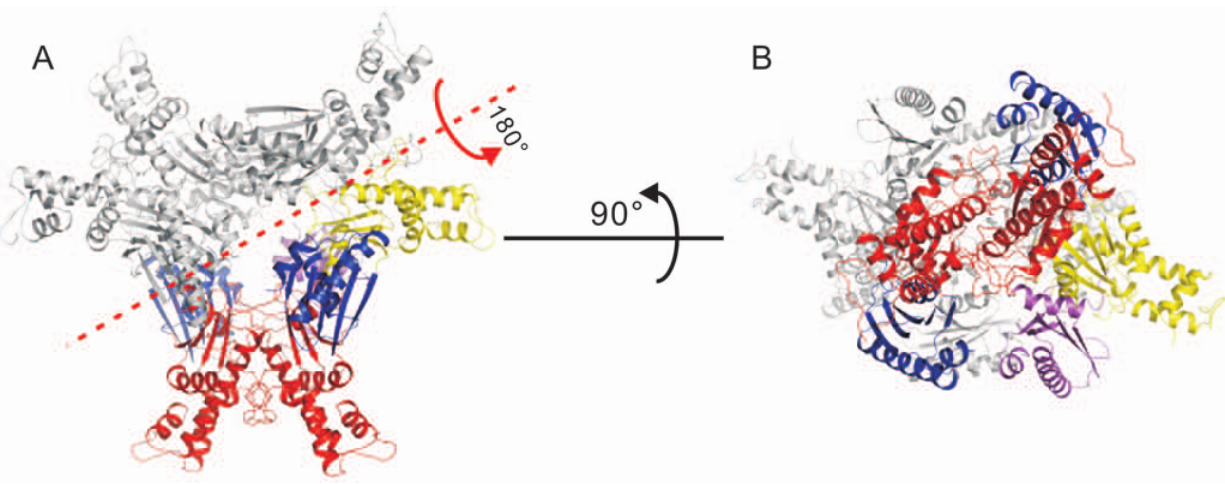
Figure 5. Crystallographic hexamer. Panel A: A crystallographic hexamer is produced by applying a two-fold rotational symmetry operation (red axis) on the three molecules in the asymmetric unit. The N-lobes of the dimer in the biological unit are shown in blue while the C-lobe in red. The N- lobe of the third molecule that forms a dimer with a symmetry-related molecule is shown in magenta, and the C-lobe in yellow. The three symmetry- related molecules are in grey. Panel B: A bottom-up view of the hexamer by rotating the hexamer in panel A over 90 u along x-axis. The N-lobes of each dimer are located on the opposite sides of the hexamer.